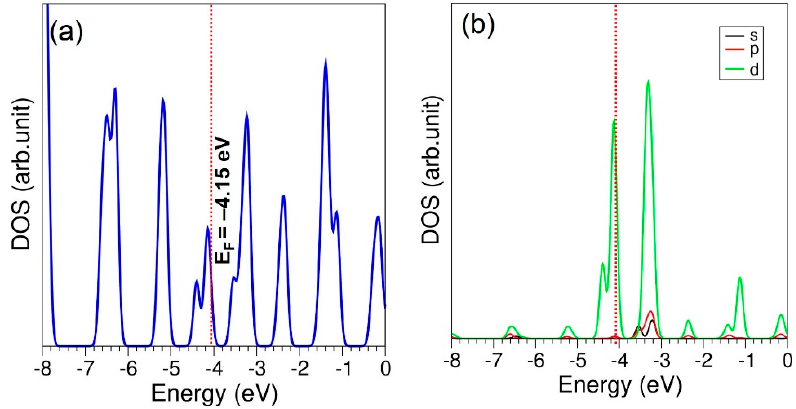
Figure 5. ( a ) Total DOS plot and ( b ) atomic DOS plot of Ti. A single CO 2 molecule was allowed to adsorb on the surface of Ti-supported C 60 . The relaxed configuration is shown in Figure 6a. In this structure, the CO 2 molecule exhibits a nonlinear structure. There is a significant elongation in the bond lengths of C-O in comparison with those found in molecular CO 2 (1.18 Å) (see Figure 6b). This indicates that depletion of CO 2 can be enhanced by the support of Ti on the surface of C 60 . The Bader charge analysis shows that the net charge on the CO 2 molecule is − 1.19.